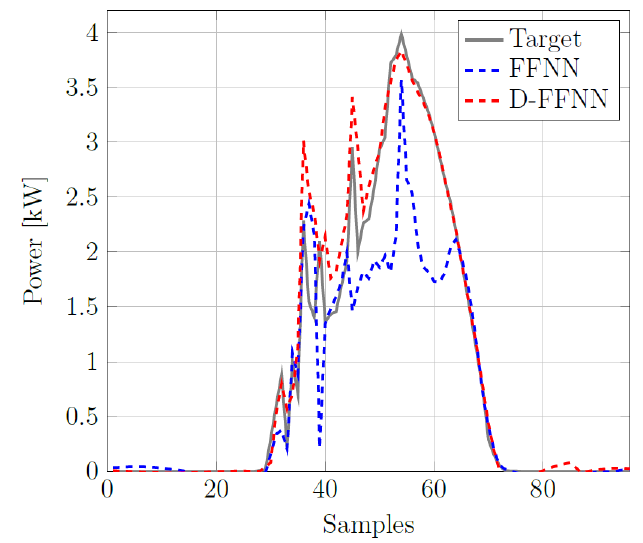
Figure 17. Prediction of a partly intermittent day, having a quite irregular shape, 10 January 2019: the continuous line indicates the real measurements and the discontinuous line refers to the D-FFNN predicted